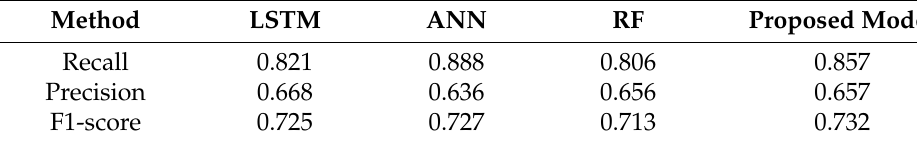
Table 4. Model prediction performances after 3 h at Location B.